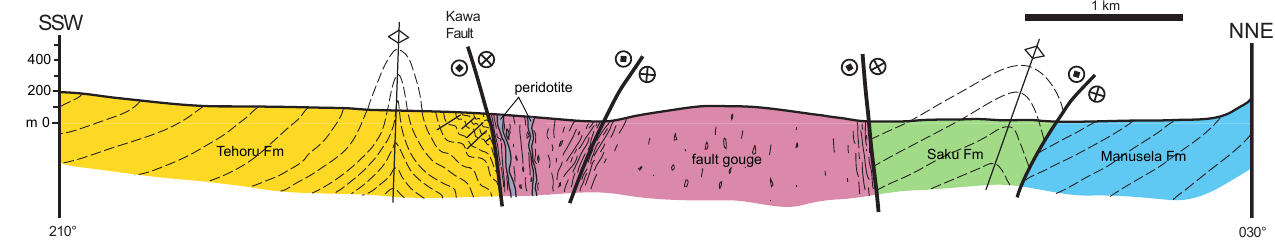
Fig. 12. Cross section through the Kawa Fault Zone in the vicinity of the Trans-Seram Highway as mapped in Fig. 11.